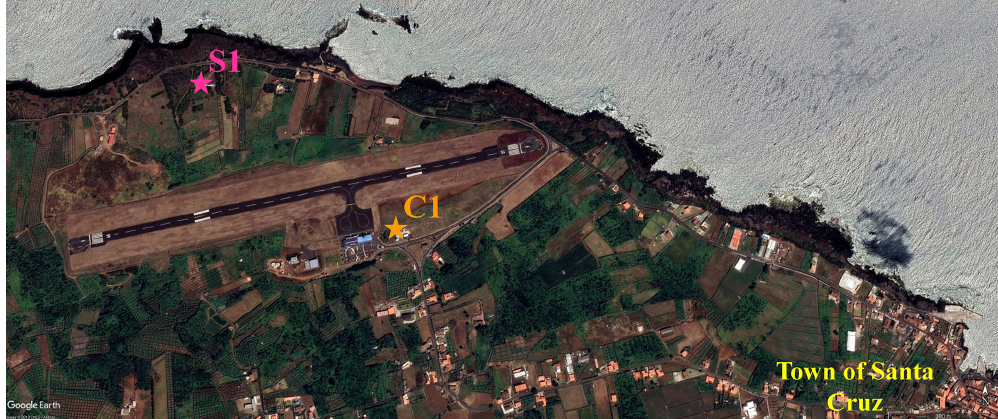
Figure 1. Satellite image of ENA C1 and S1 on Graciosa Island, Azores, Portugal (© Google